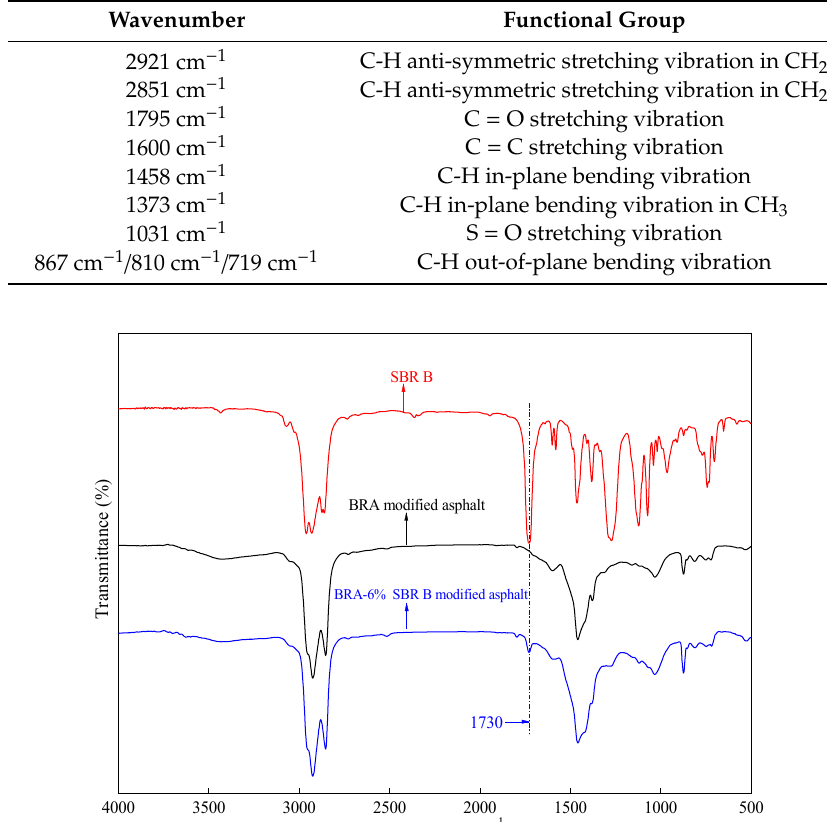
Table 5. Functional group of BRA modified asphalt.